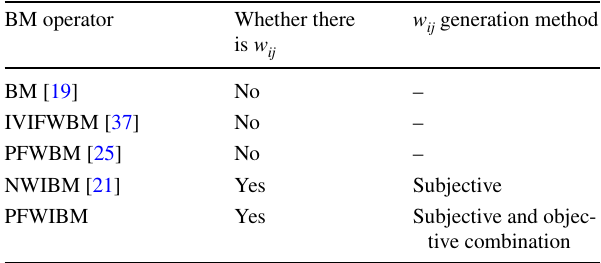
Table 14 Comparison of interaction coefficients of different BM operators BM operator